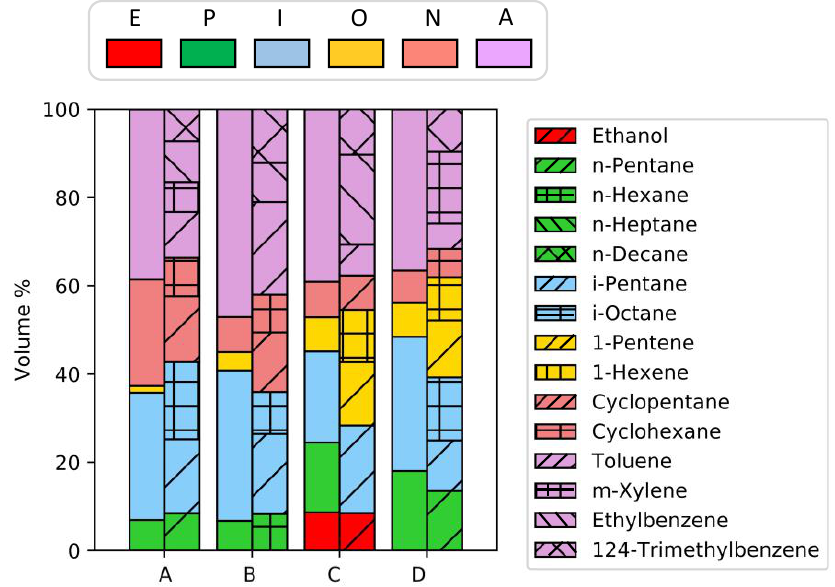
Figure 5. Volumetric composition of the optimum surrogate (filled bars) for the four validation gasolines: the filling color represents the EPIONA composition; the filling pattern represents the constituting pure compounds. Experimental EPIONA volumetric composition (empty bars) is also provided.